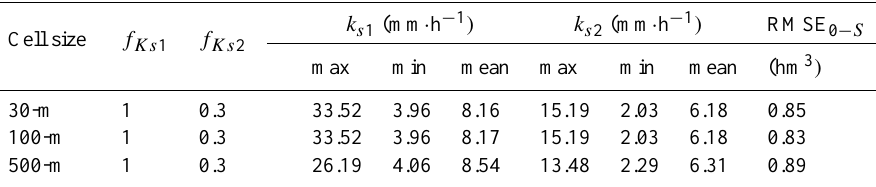
Table 4. Calibrated factors for the surface and soil saturated hydraulic conductivity parameters, f Ks 1 and f Ks 2 , respectively, and mean, maximum, and minimum individual final values for 30-m, 100-m, and 500-m cell